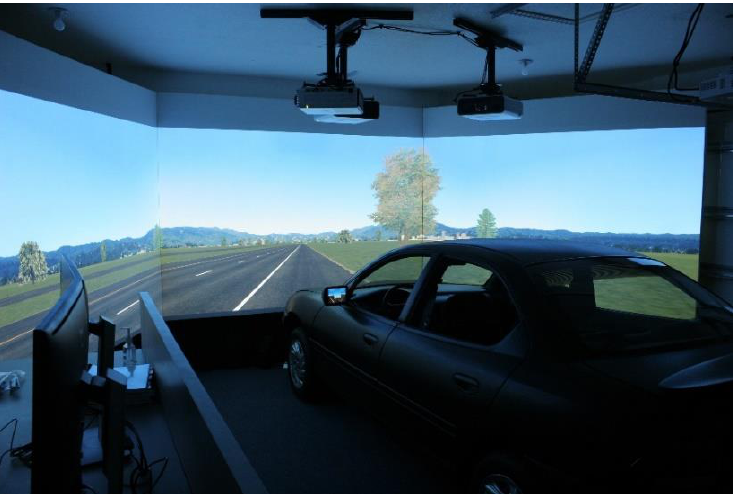
Figure 1. Realtime Technologies Inc. (RTI) High Fidelity Driving Simulator (Level 4, SAE).